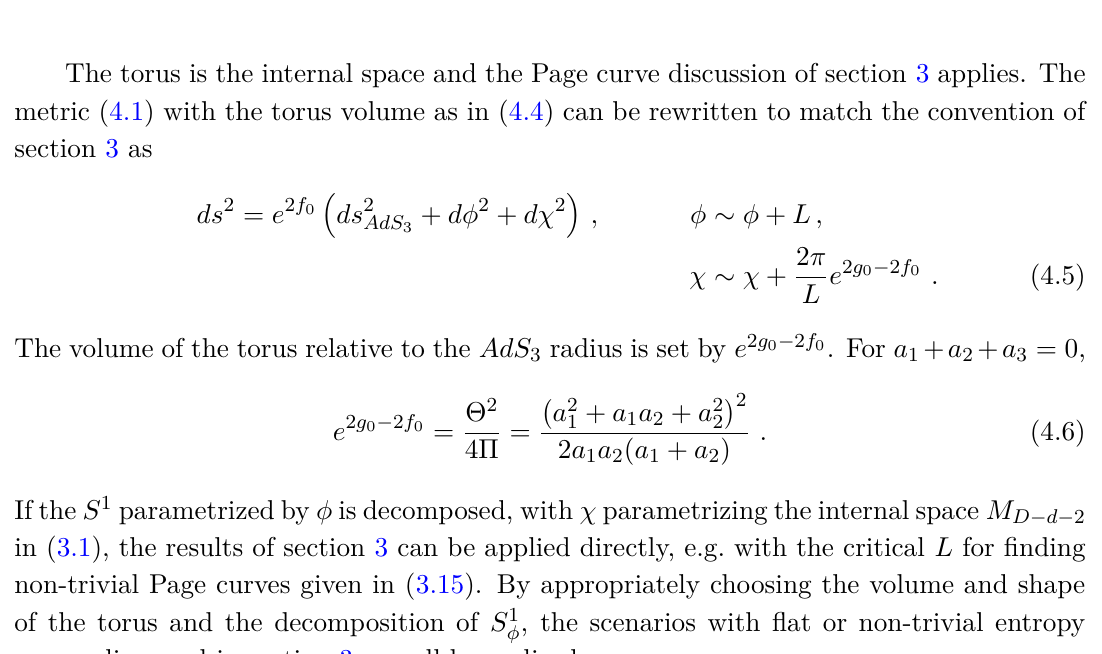
Figure 6 . AdS 5 → AdS 3 × T 2 flow solutions for ( a 1 , a 2 ) ∈ { (1 , 2) , (3 , 4) , (3 , 3) } in (blue, yellow,